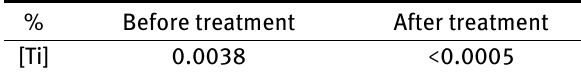
Table 6: Ti content in steel before and after treatment (mass %) % Before